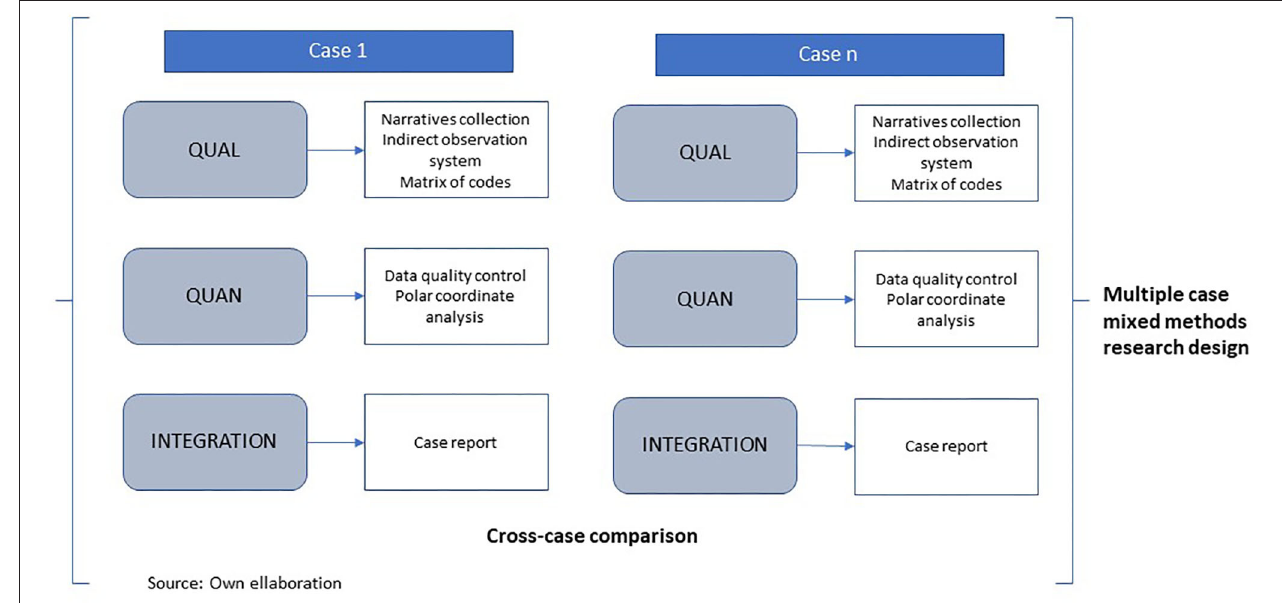
FIGURE 2 | Research design. Source: Own